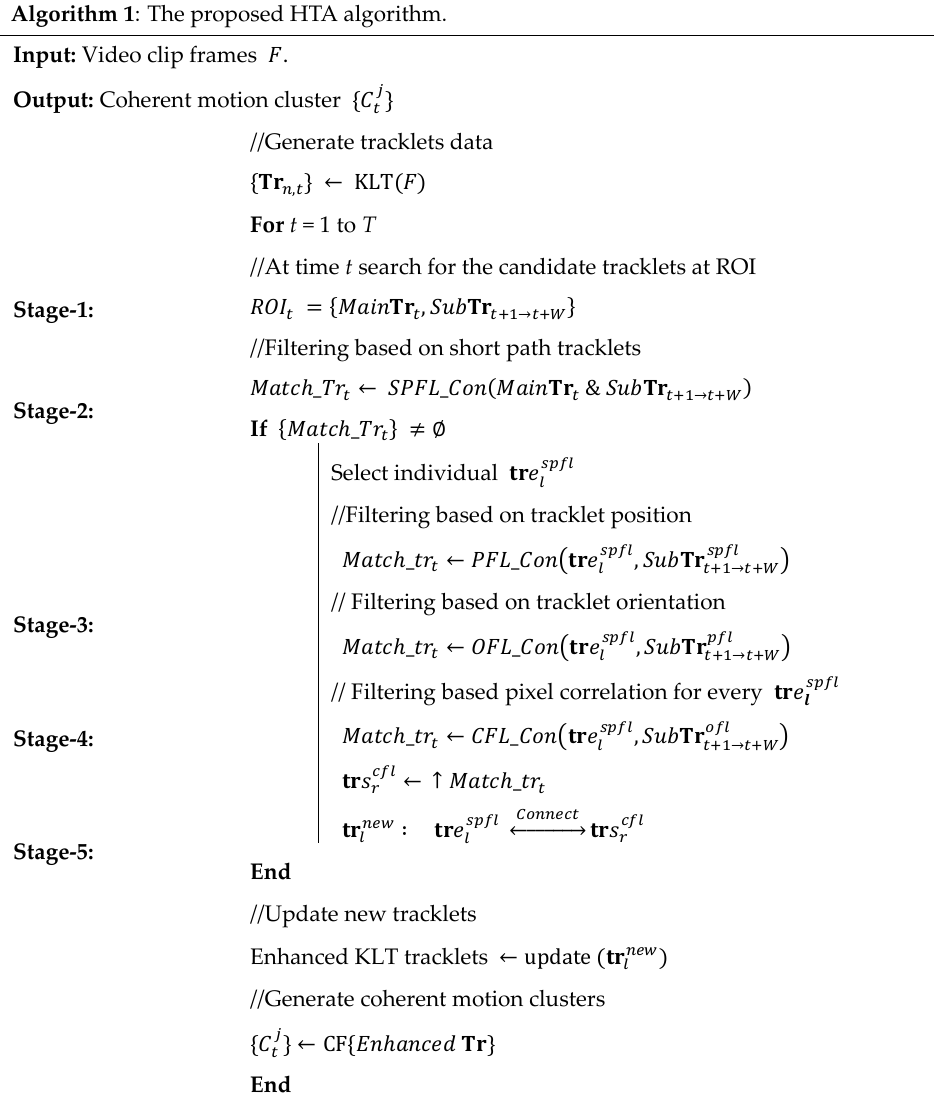
Algorithm 1 : The proposed HTA algorithm. Algorithm 1: The proposed HTA